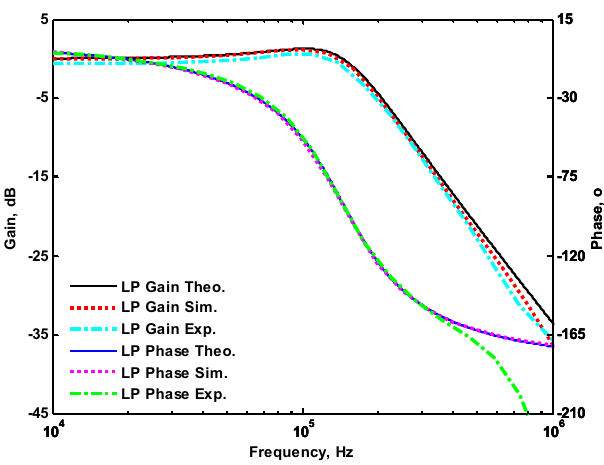
Figure 10. Experimental and simulated LP filters with theoretical responses in case II.